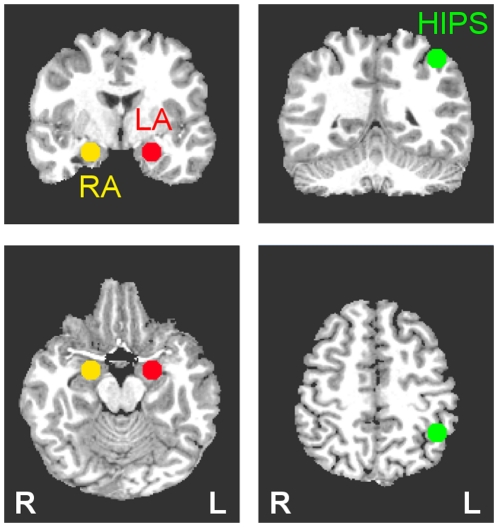
Regions of Interest (ROIs) for the Real-time fMRI Neurofeedback Procedure.Three regions of interest (spheres of 7 mm radius) were used to assess changes in BOLD activity in the left amygdala (LA, red), right amygdala (RA, yellow), and left horizontal segment of the intraparietal sulcus (HIPS, green). The ROI placements are illustrated on T1-weighted coronal (upper row) and axial (lower row) human brain sections in the Talairach space. Following the radiological notation, the left side (L) of the brain is shown on the right, and the right side (R) of the brain – on the left.